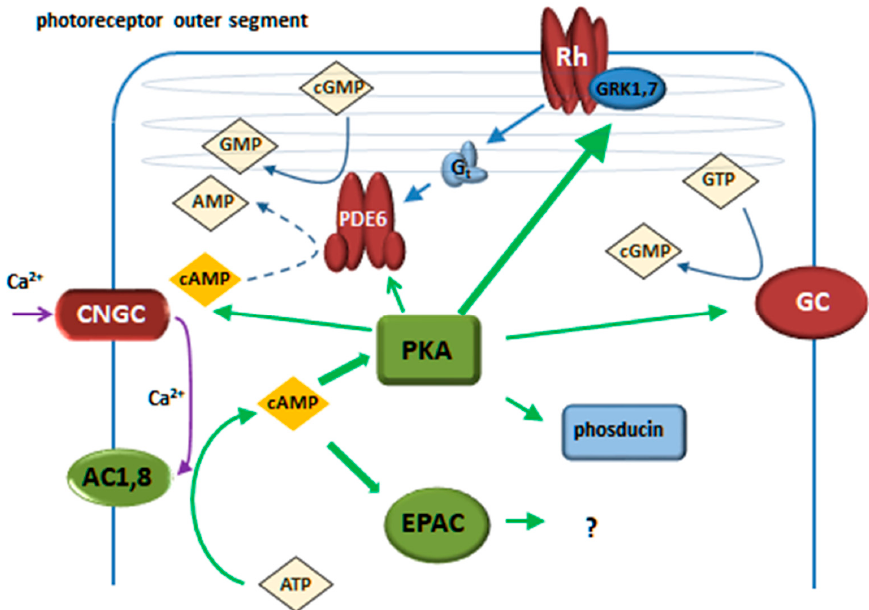
Figure 1. Schematic of the known and putative pathways of cAMP action on the phototransduction cascade. Proteins traditionally implicated in the phototransduction cascade are brown: CNGC—cGMP-gated cyclic nucleotide-gated ion channels, GC—guanylate cyclase, PDE6—cGMP-specific phosphodiesterase type 6, and Rh—rhodopsin; regulatory proteins are blue: G t —G-protein transducin, GRK1,7—rhodopsin kinase type 1 or 7, and phosducin. Blue arrows indicate known enzyme activities and interactions between these proteins. Green figures indicate proteins involved in proven or putative loops of cAMP action on the phototransduction cascade: AC(1,8)—adenylate cyclase type 1 or 8, PKA—cAMP-dependent protein kinase, and EPAC—exchange protein directly activated by cAMP. Green arrows indicate proven or putative cAMP action. Hypothetical utilization of cAMP by PDE6 is shown by a do tt ed line.